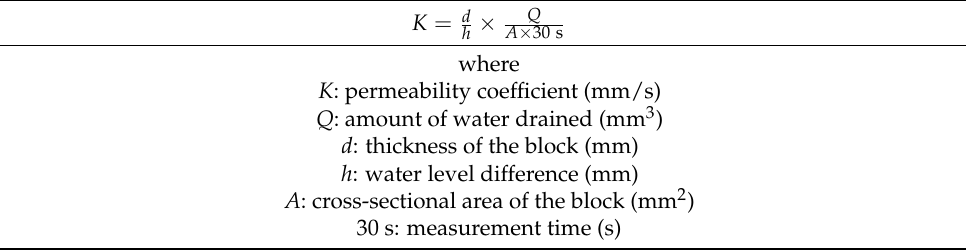
Table 6. Permeability coefficient calculation formula.